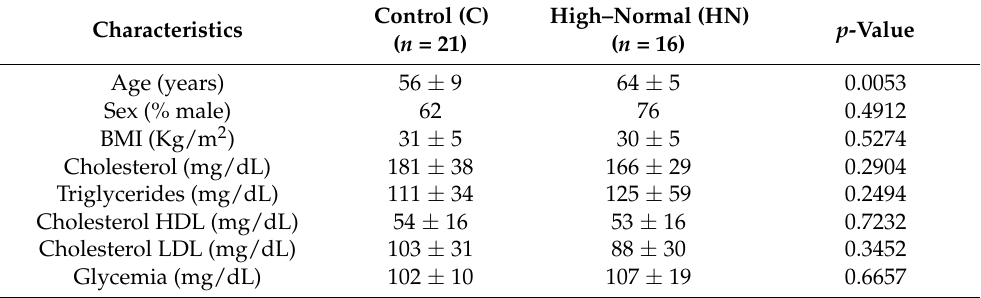
Table 1. Baseline clinical data of hypertensive patients under chronic RAS suppression classified into the control group (ACR < 10 mg/g) and high–normal group (ACR = 10–30 mg/g). Data are shown as average ± standard